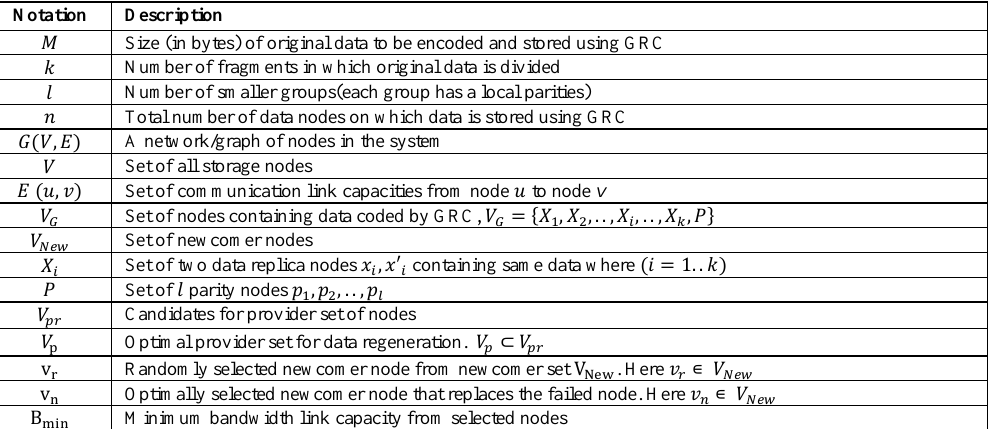
Table 1. Notations used for data regeneration in Group Repair